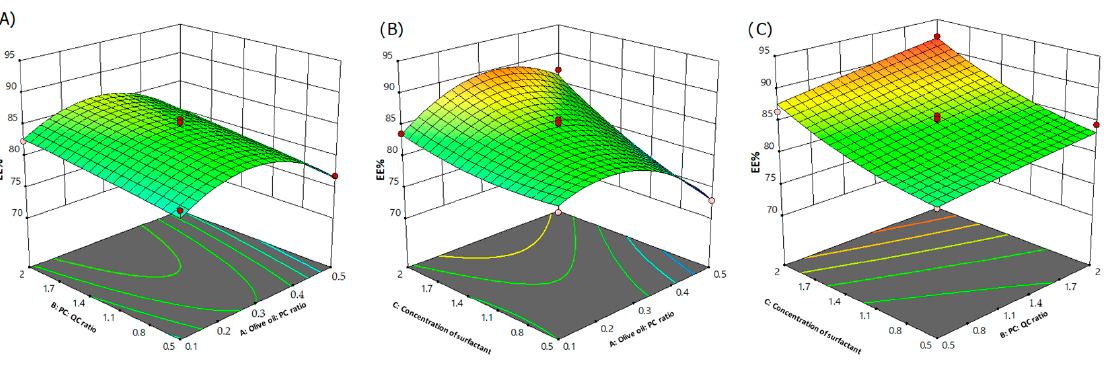
Figure 4. Three-dimensional response surface plots indicating the combined influence of: ( A ) olive oil/PC and QC/PC ratios, ( B ) olive oil/PC ratio and concentration of surfactant and ( C ) QC/PC ratio and concentration of surfactant on EE%.